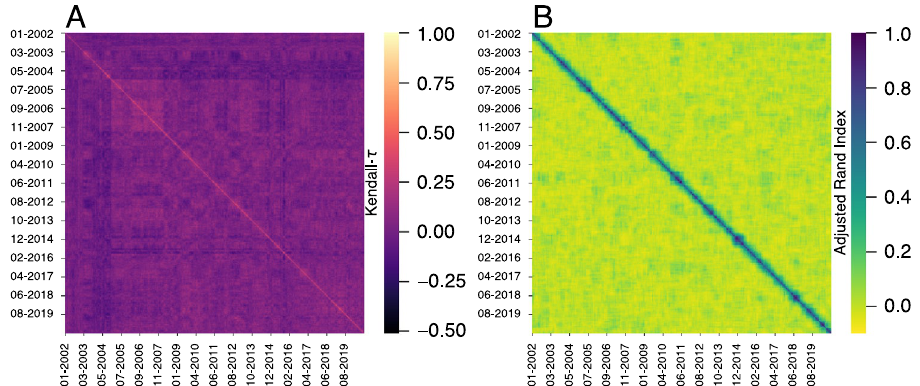
Figure 3. Short-term stability of efficiency rankings and clusterings of stock markets. ( A ) Matrix plot of the Kendall rank correlation coefficient (Kendal- τ ) among all pairs of efficiency ranks of stock markets calculated within a 1-year sliding window. We note the formation of small diagonal blocks with widths of 1 or 2 months, indicating that the efficiency ranks change over time. ( B ) Matrix plot of the adjusted rand index estimating the agreement among clustering of markets with similar temporal efficiency profiles at different time-windows. We also observe the existence of small diagonal blocks with widths of approximately 4 months, showing that groups with similar efficiency profiles do not remain stable during long